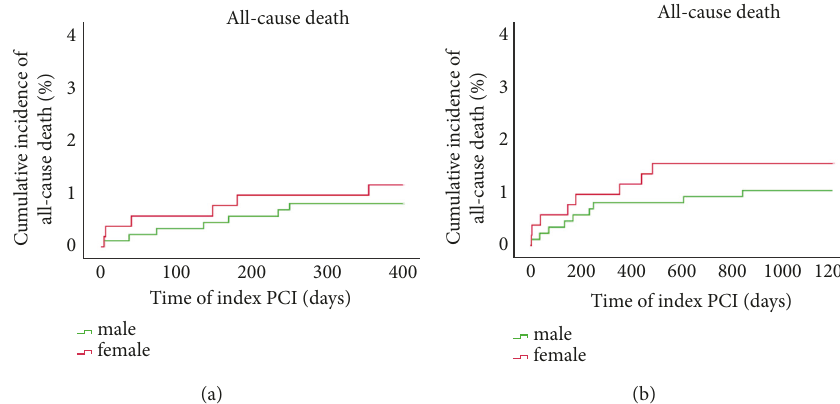
Figure 1: Survival analysis: Kaplan–Meier curves for all-cause death (a) at one year and three years (b) comparing males and females with PCAD.